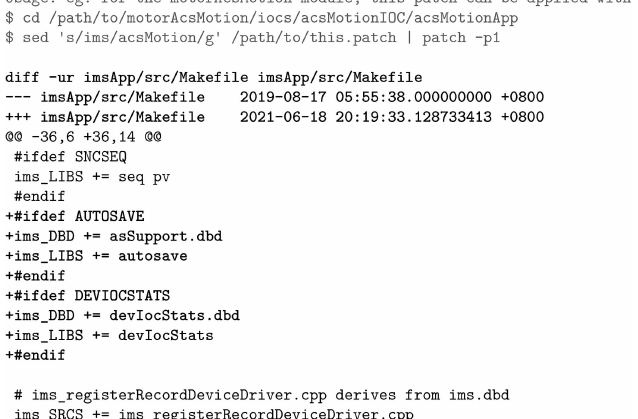
Figure 6 A ‘template’ used to batch-add support for iocStats and autosave to motor